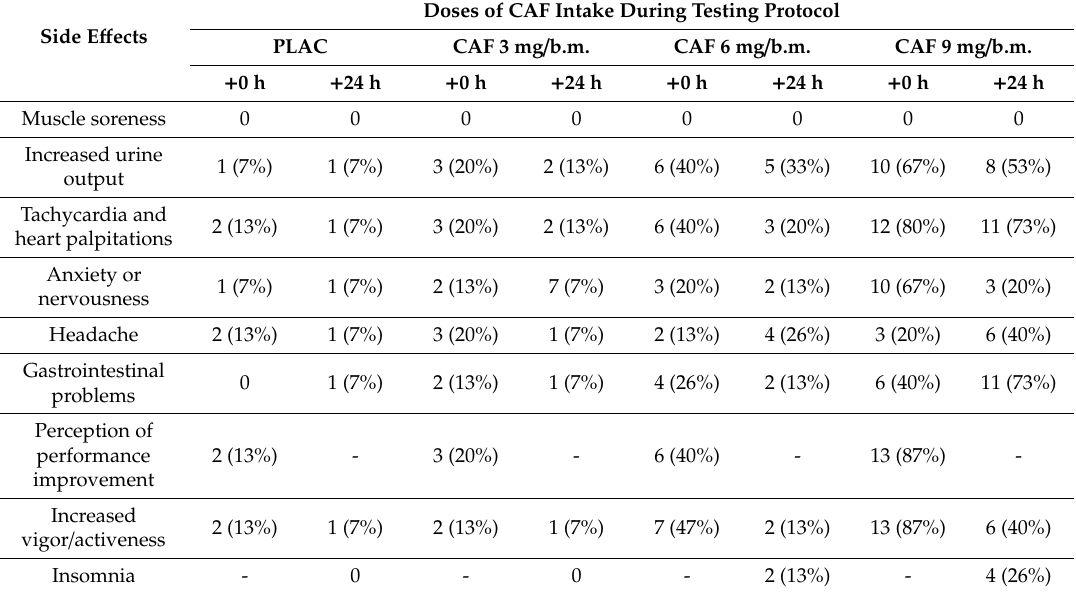
Table 5. Side e ff ects reported by participants immediately after the testing protocol (QUEST + 0 hours) and 24 hours later (QUEST + 24